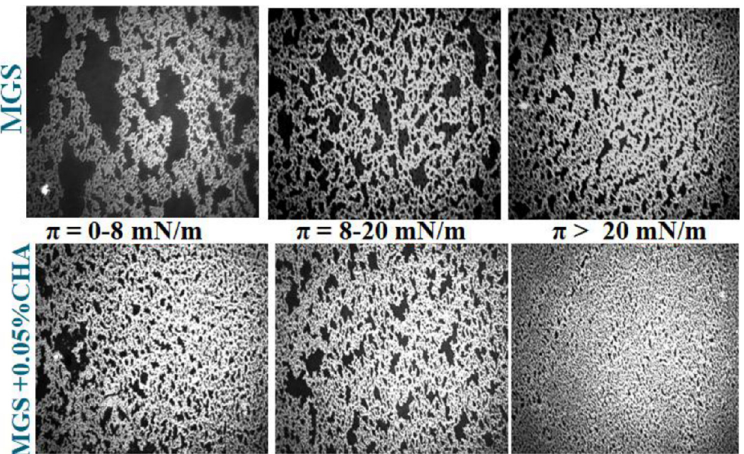
Figure 5. Effects of CHA on the morphology of meibomian films, as observed by BAM (image width is 500 µm).